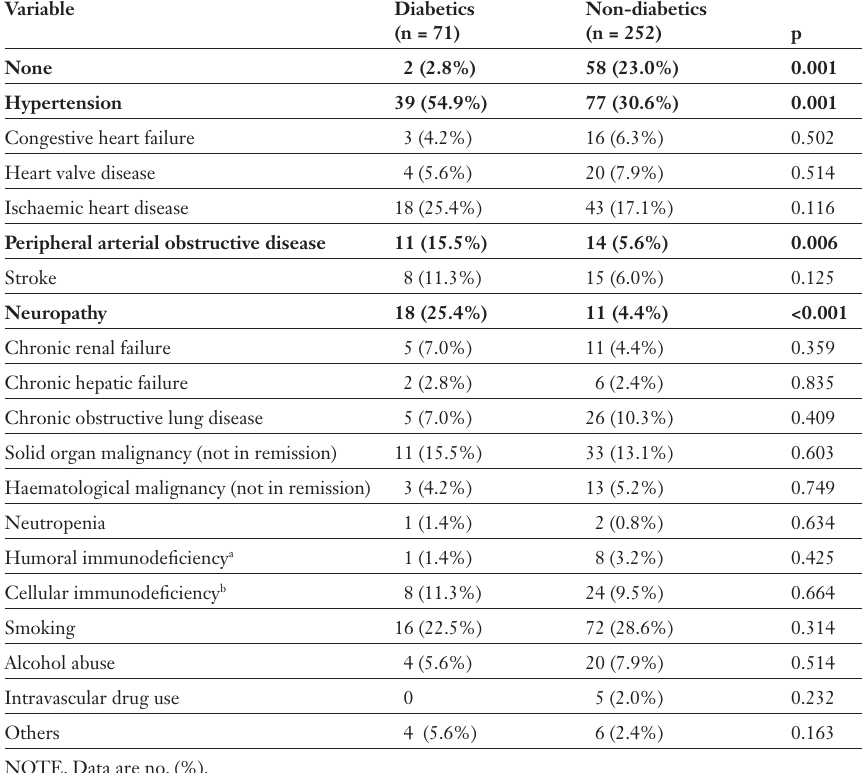
Underlying conditions.